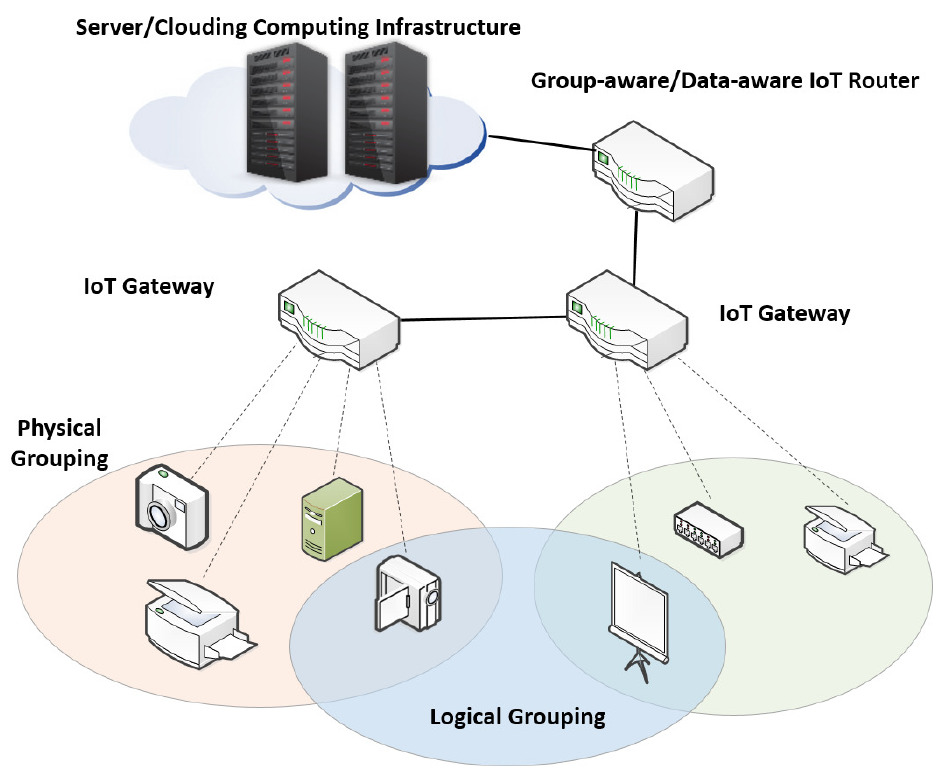
Figure 4. The concept of physical grouping and logical